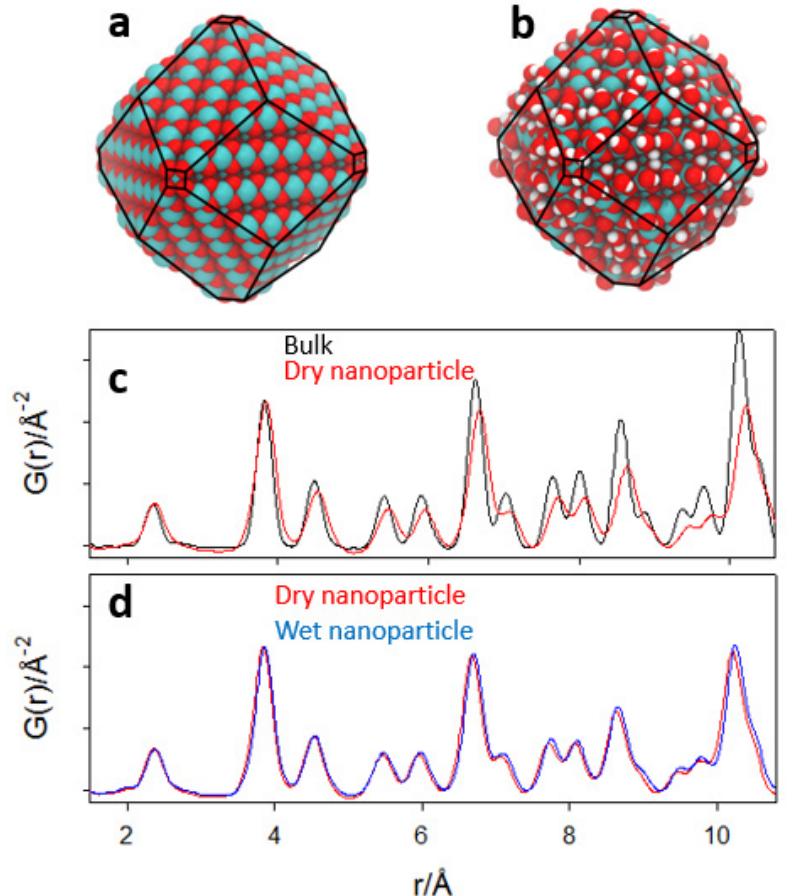
Figure 9. Force field computed dry ( a ) and wet ( b ) relaxed nanoparticles. ( c , d ) computed G( r ) curves of bulk (black curve), dry (red curve) and wet (blue curve) nanoparticles.